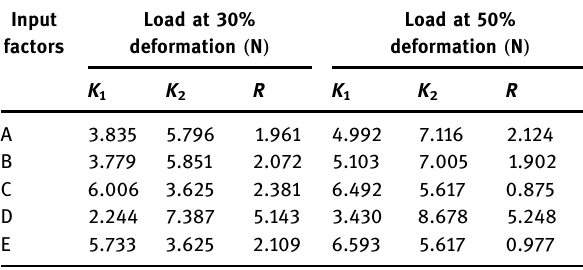
Table 5: Range analysis for the compression load at 30% and 50% compression deformation